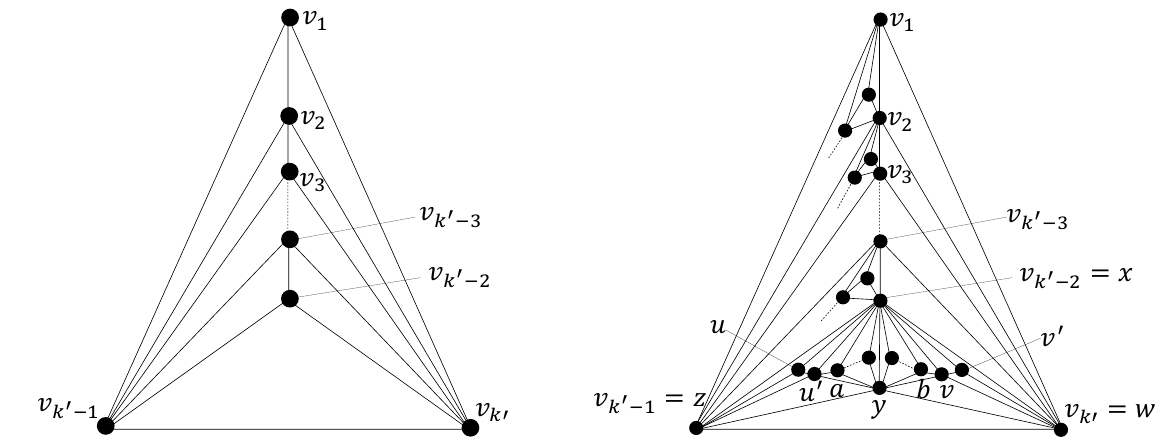
Figure 2: A standard form H with k ′ vertices Figure 3: A graph G obtained from